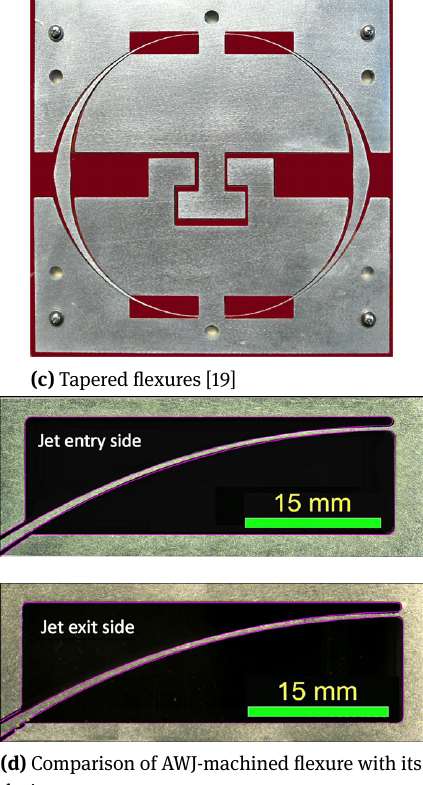
Figure 4: Aluminum nonlinear load